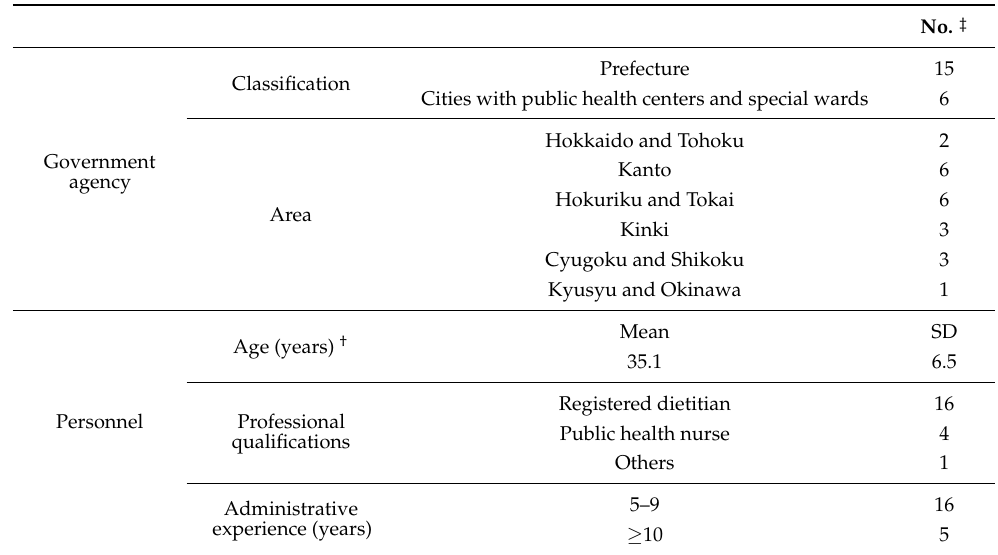
Table 3. Characteristics of the health personnel including their government agency of origin, area, professional qualifications, and administrative experience (n =